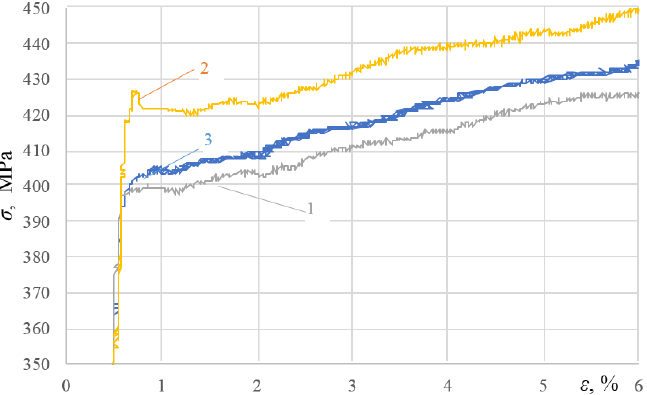
Figure 6. Diagrams of investigated alloys deformation under static tension after DNPs of different intensities: 1—alloy D16ChATW ( ε imp = 4.26%); 2—alloy 2024-T351 ( ε imp = 3.72%); 3— alloy T ( ε imp = 4.06%).